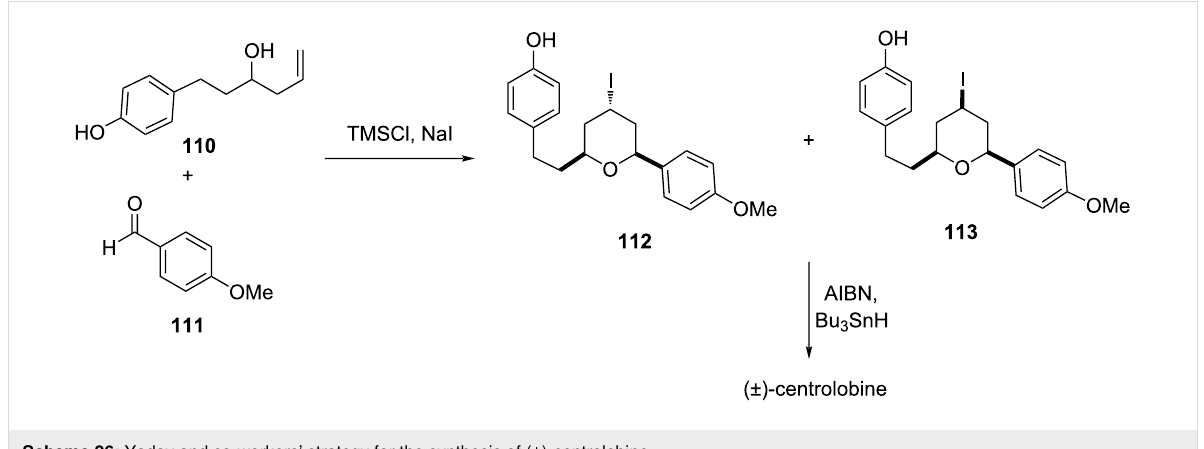
Scheme 26: Yadav and co-workers’ strategy for the synthesis of (±)-centrolobine.